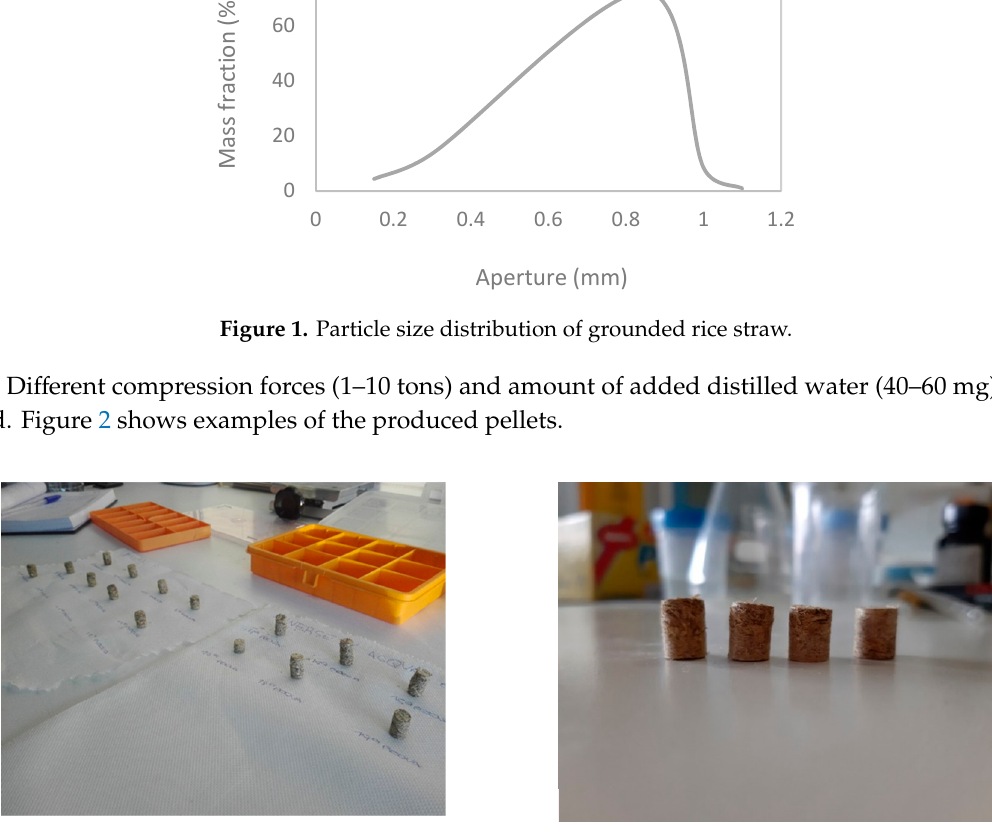
Figure 1. Particle size distribution of grounded rice straw.